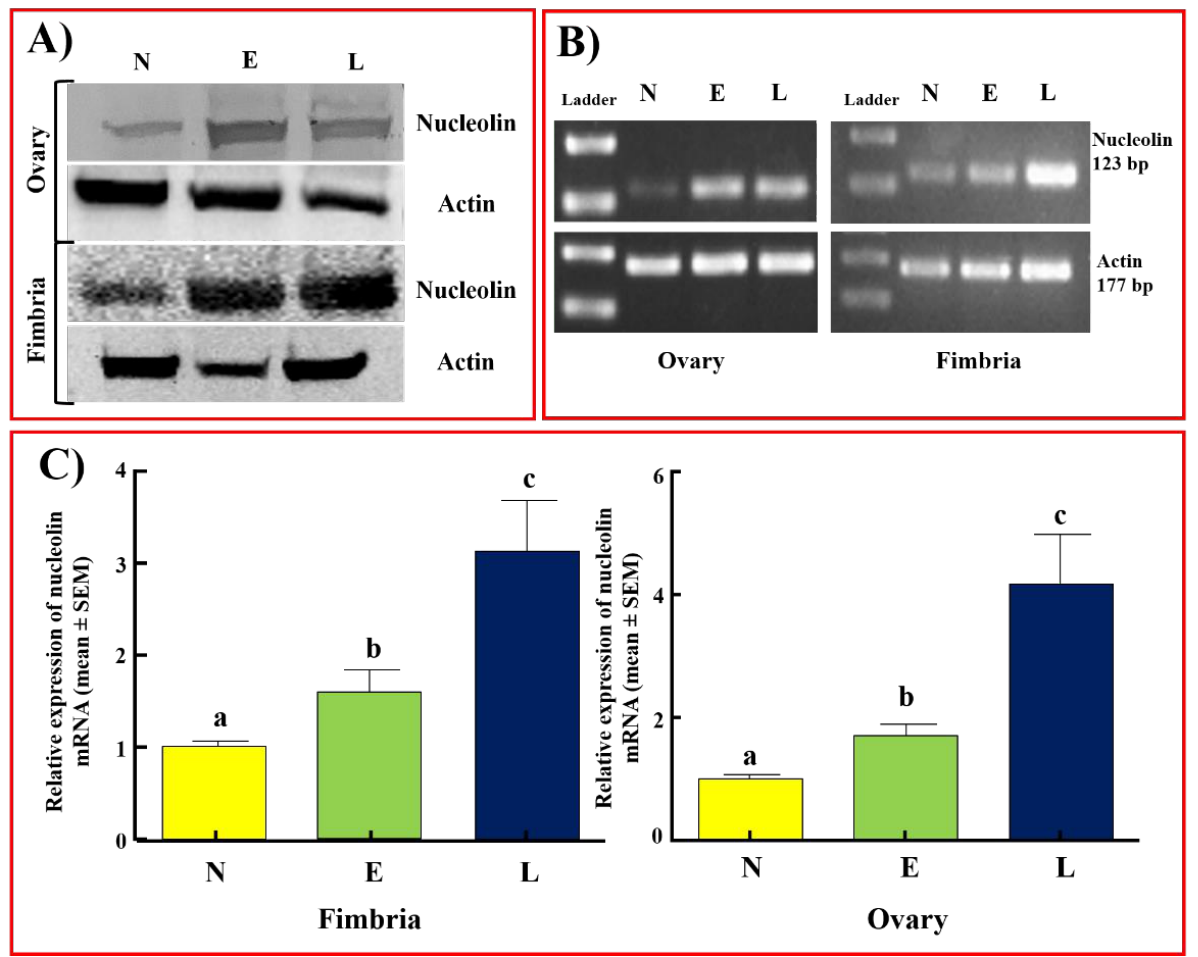
Figure 6. Changes in nucleolin expression during ovarian HGSC development in hens as detected by immunoblotting and gene expression assays. ( A ) Immunoblotting of ovarian or fimbrial tumor homogenates from hens with ovarian HGSC at early and late stages showed intense nucleolin expression, while normal ovarian or fimbrial homogenates showed weaker expression for nucleolin. ( B ) Semiquantitative (RT-PCR) gene expression assays showed stronger expression for NCL (nucleolin gene, 123 bp) in fimbrial or ovarian HGSC tumors than in normal ovary or fimbria. ( C ) Quantitative RT-PCR assays for NCL gene expression. Each bar represents the expression of the NCL gene in hens with normal ovaries ( n = 4) or fimbriae ( n = 4), and ovaries or fimbriae with tumors at early and late stages ( n = 4 each) of HGSC. Compared with normal ovaries or fimbriae, the expression of the NCL gene was significantly higher ( p < 0.01) in both ovarian and fimbrial HGSC at early stages and expression increased further in late stages ( p < 0.001). Bars with different letters are significantly different in NCL gene expression (normal ovary vs. early-stage ovary p < 0.001; normal ovary vs. late-stage ovary p < 0.0001; normal fimbria vs. early-stage fimbria p < 0.01; normal fimbria vs. late-stage fimbria p < 0.001). Actin served as a loading control. Bp = base pair. E = early-stage HGSC, L = late-stage HGSC, N =